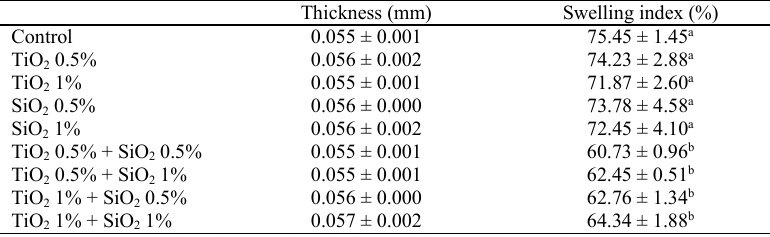
) and Silicon dioxide (SiO ) nanoparticles. 2 2